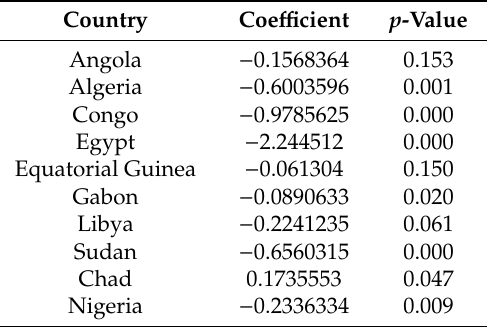
Table 12. Short-run ECTs, sampled countries.